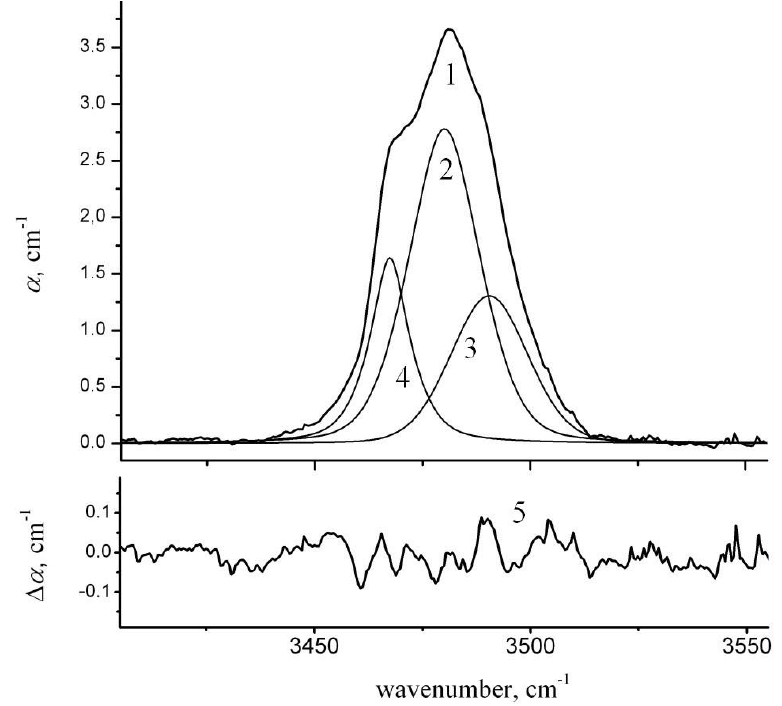
Figure 5. IR spectrum of CLN2: (1) integrated IR absorption spectrum of the CLN2 sample; (2)–(4) spectrum components; and (5) difference function ∆ α .